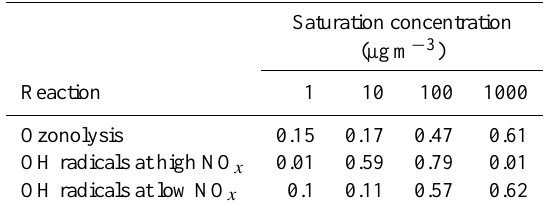
Table 3. Product mass yields for the three different reactions using a four-product volatility basis set. Saturation